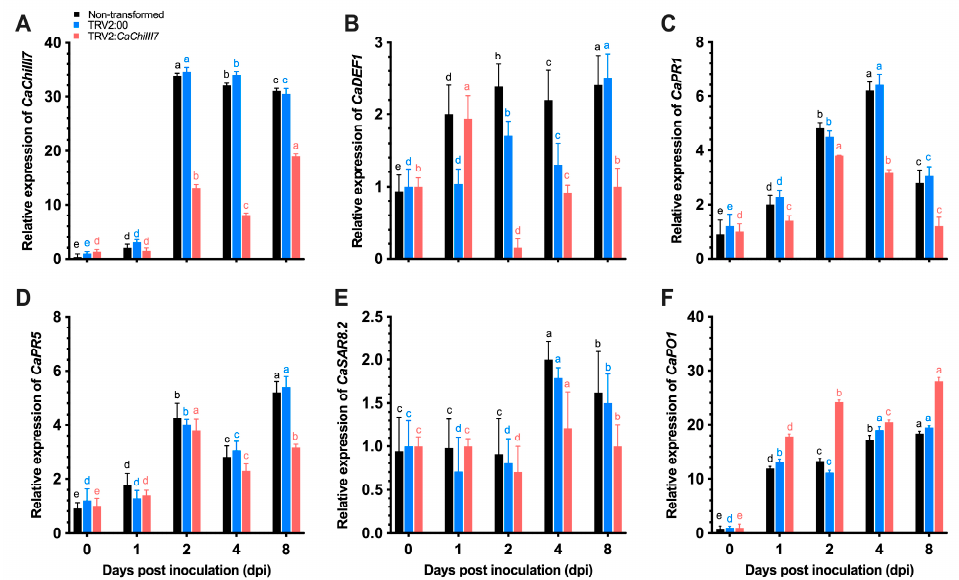
Figure 5. Qualitative real-time polymerase chain reaction (qRT-PCR) analyses of CaChiIII7 transcription and defense-response genes in CaChiIII7 -silenced (TRV2: CaChiIII7 ) and control (non-transformed, TRV2:00) pepper leaves inoculated with Colletotrichum acutatum . ( A ) CaChiIII7 (chitinase); ( B ) CaDEF1 (defensin); ( C ) CaPR1 (pathogenesis-related 1); ( D ) CaPR5 (pathogenesis-related; 5) ( E ) CaSAR8.2 (systemic acquired resistance); ( F ) CaPO1 (peroxidase). Defense genes were selected based on protein-protein interactions, Figure 2B. The control sample values were set to 1 for normalizing the transcription levels of other genes. Data are the means with standard deviations ( ± SD) and lower-case letters (a–e) indicate significant di ff erences as analyzed by a Duncan’s multiple range (DMR) test ( p <